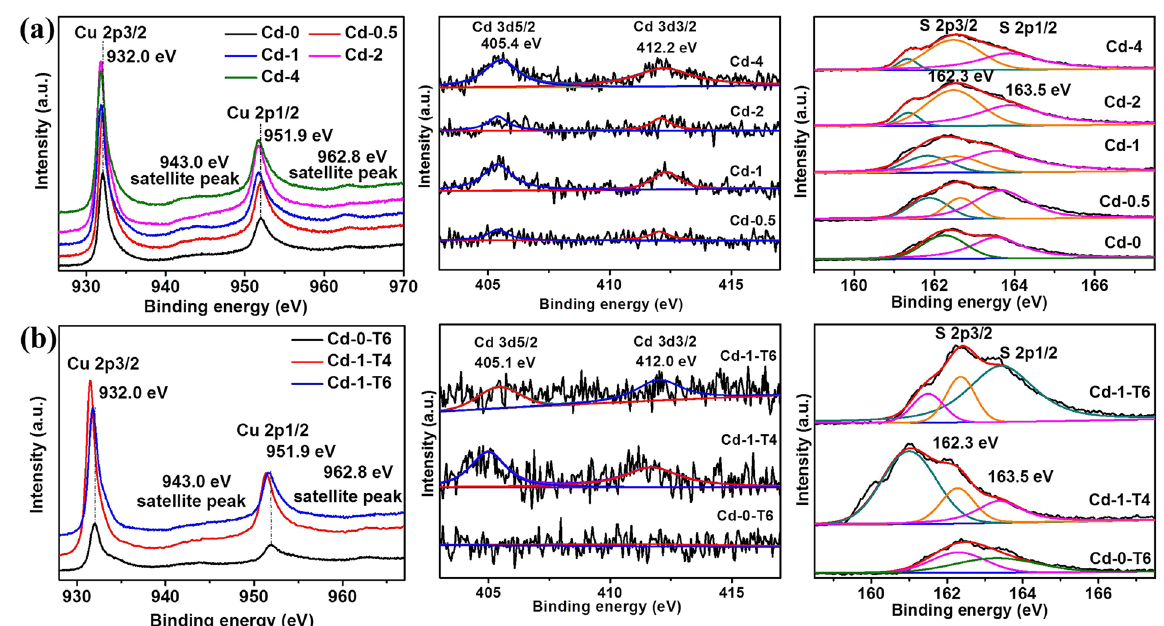
Figure 7. XPS analysis of as-synthesized samples in the Cu 2p, Cd 3d and S 2p regions. ( a ) Samples prepared by changing the amount of Cd content with fixing thiourea, and ( b ) Samples obtained by modulating the contents of both Cd and